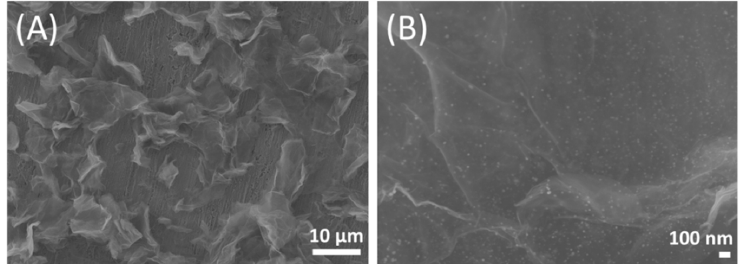
Figure 1. Scanning electron microscope (SEM) images of Ag-AuNPs/RGO magnified 1500 times ( A ); and 33,000 times ( B ).